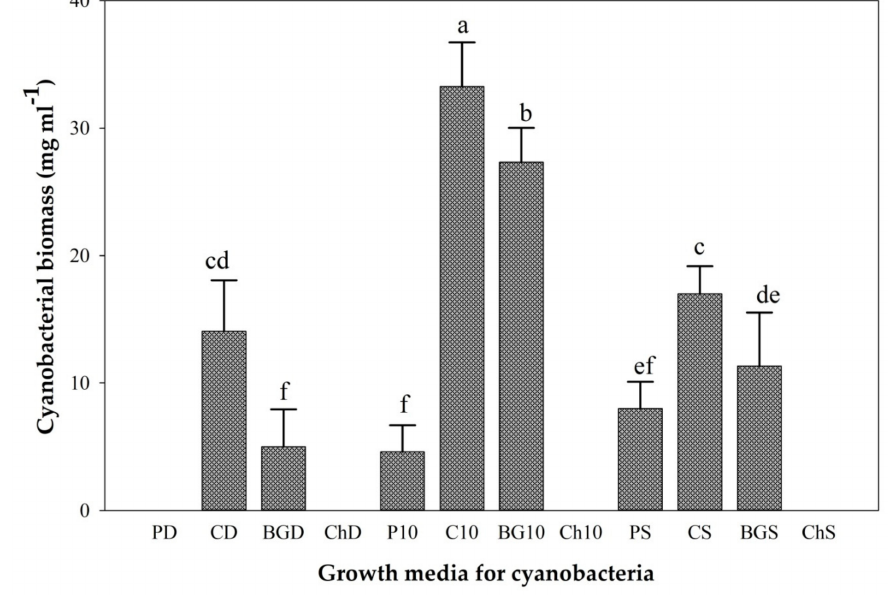
Figure 5. E ff ects of di ff erent animal manures and seawater dilution on HSaC cyanobacterial biomass. PD = pig manure in distilled water, CD = cow manure in distilled water, BGD = BG11 in distilled water, ChD = chicken manure in distilled water, P10 = pig manure in diluted seawater (EC 10 dS / m), C10 = cow manure in diluted seawater (10 dS / m), BG10 = BG11 in diluted seawater (10 dS / m), Ch10 = chicken manure in diluted seawater (10 dS / m), PS = pig manure in seawater, CS = cow manure in seawater, BGS = BG11 in seawater and ChS = chicken manure in seawater. The error bars represent standard deviations (SDs). The data are the mean of three replicates. Di ff ering letters indicate significant di ff erences in means of cyanobacterial biomass in pairwise comparisons (Tukey’s test p < 0.05).